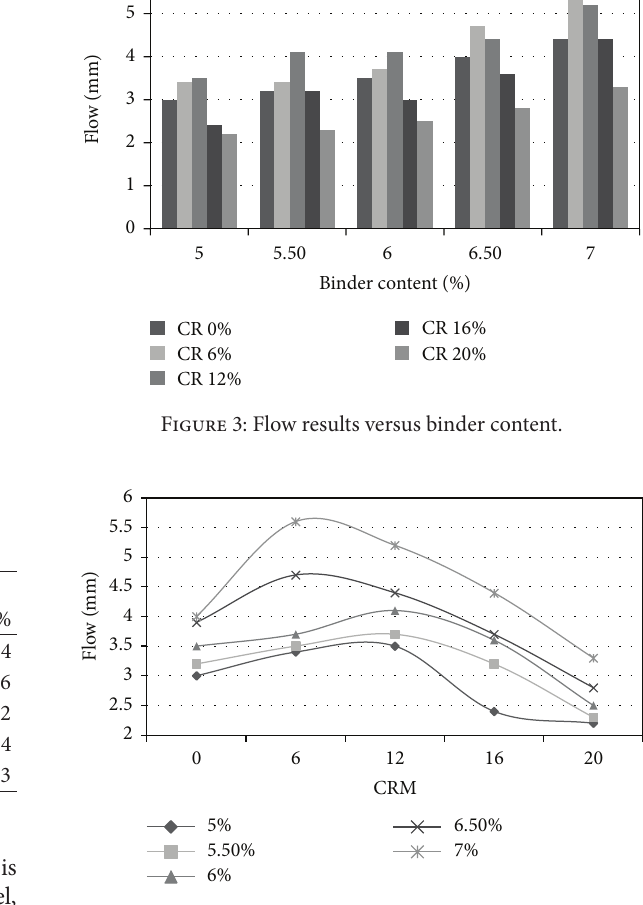
Figure 4: Flow results versus CRM